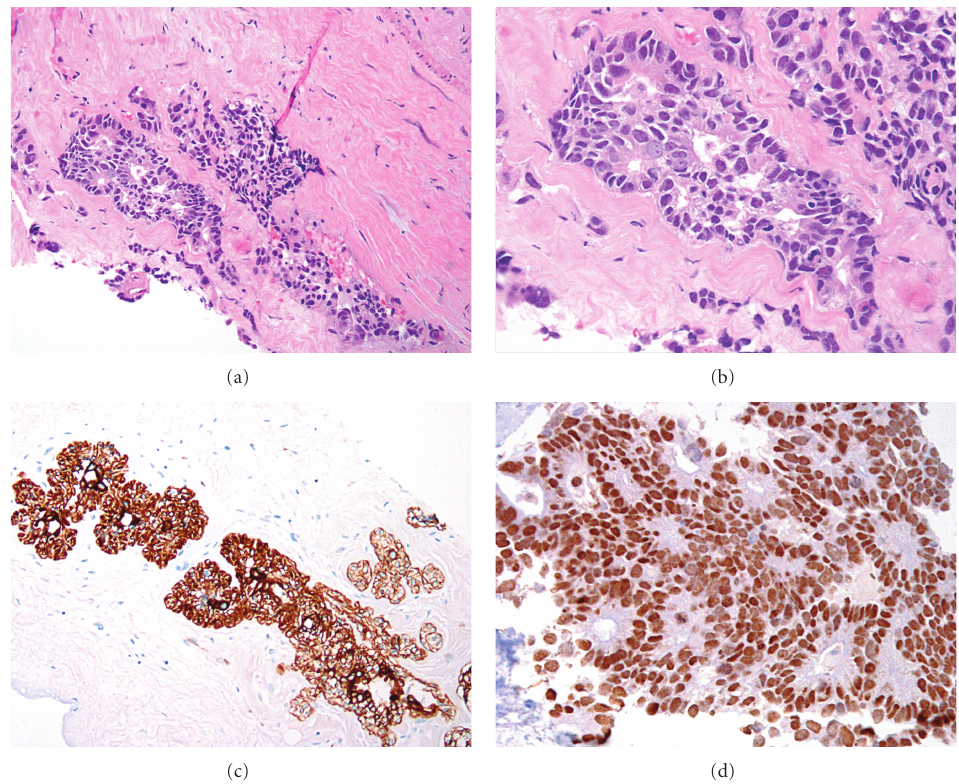
Figure 2: (a, b) The breast biopsy demonstrated an invasive adenocarcinoma with a focal cribriform pattern, hyperchromatic round to oval nuclei, and brisk mitotic activity (H&E, 100x, 200x). (c) Cytokeratin 20 showed di ff use, positive staining in the tumor (cytokeratin 20, 100x). (d) CDX2, specific for intestinal epithelium, exhibited di ff use nuclear immunoreactivity in the tumor cells (CDX2,